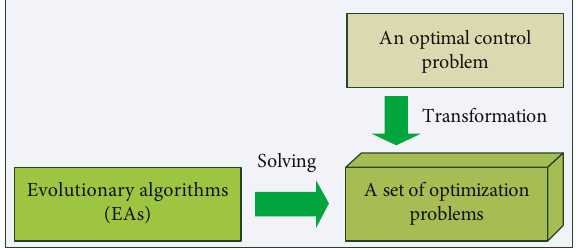
Figure 1: The schematic graph to illustrate the principle of solving an OCP by